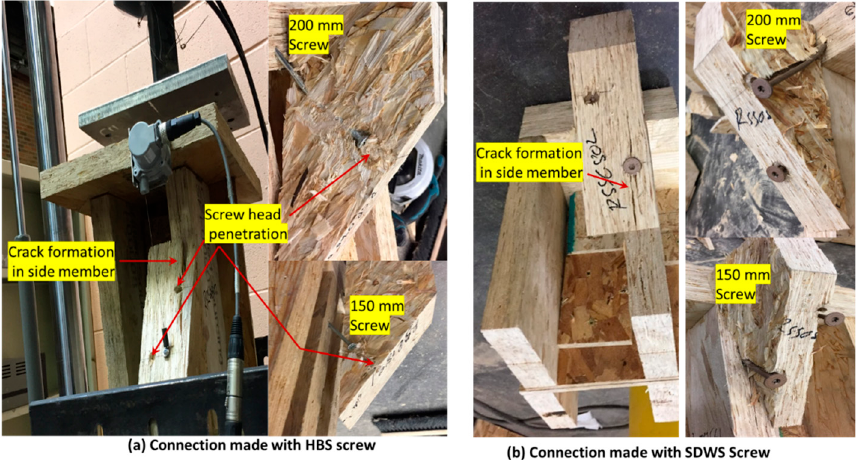
Figure 21. Failure of Connection-B: ( a ) HBS screw; ( b ) SDWS screw.